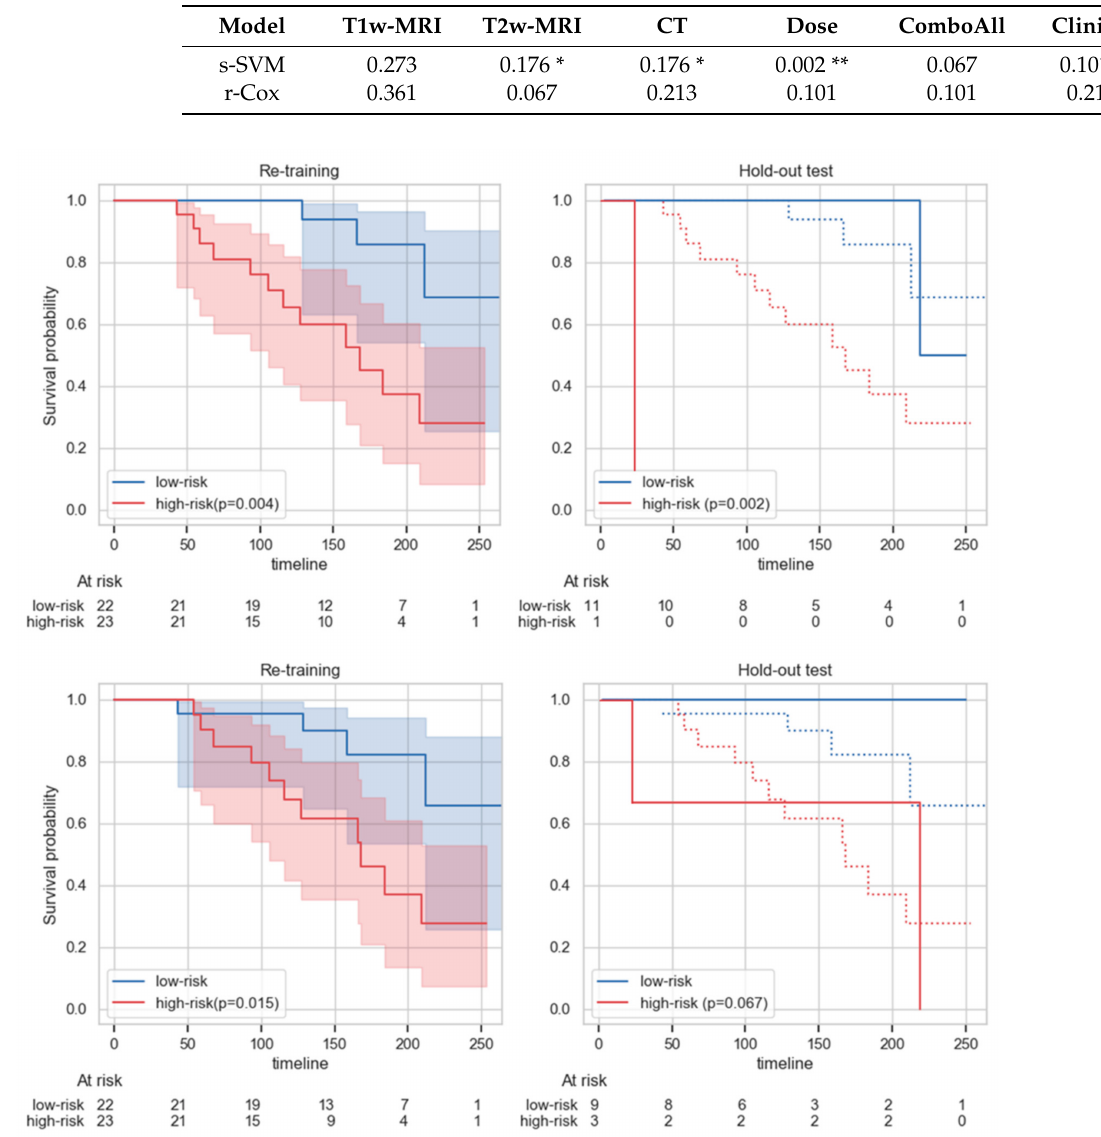
Figure 2. Kaplan Meier survival curves for patients at high-(red) and low-risk (blue) of meeting an adverse local control as stratified by s-SVM models for the best dose case (top) and comboAll (bottom), after re-training. An estimator is fit on the re-training data (left, shaded areas depict curves’ confidence intervals) and applied to the test data (continuous lines on the right; dashed lines represent the re-training curves shown on the left). Below each plot, the number of patients belonging to each risk group at certain times is shown. The p -values (p) in the legends refer to the comparison of high- and low-risk patient groups within re-training (left) or test (right) set using log-rank